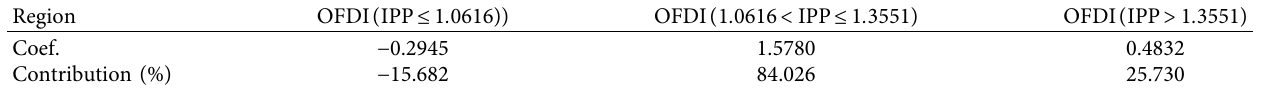
Table 6: Analysis of the contribution rate of OFDI to regional ETI capabilities. Region OFDI ( IPP ≤ 1 . 0616 ) )